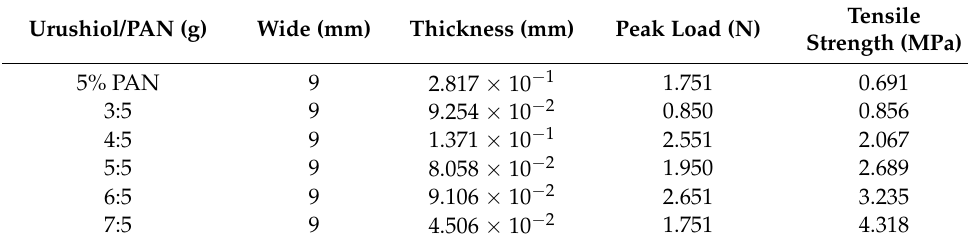
Table 3. Tensile strength results of urushiol/PAN